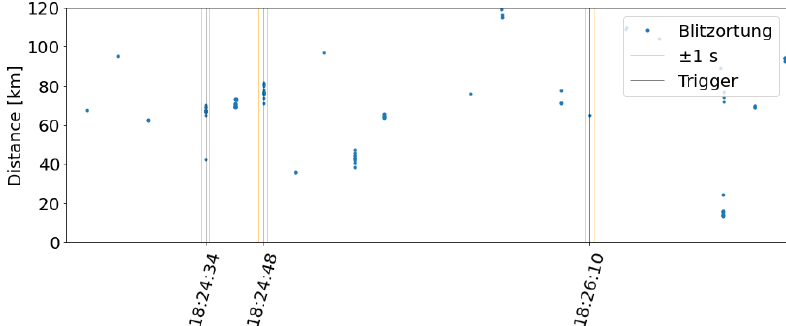
Figure 14. Correlation with “distant” (more than 40km) lightning